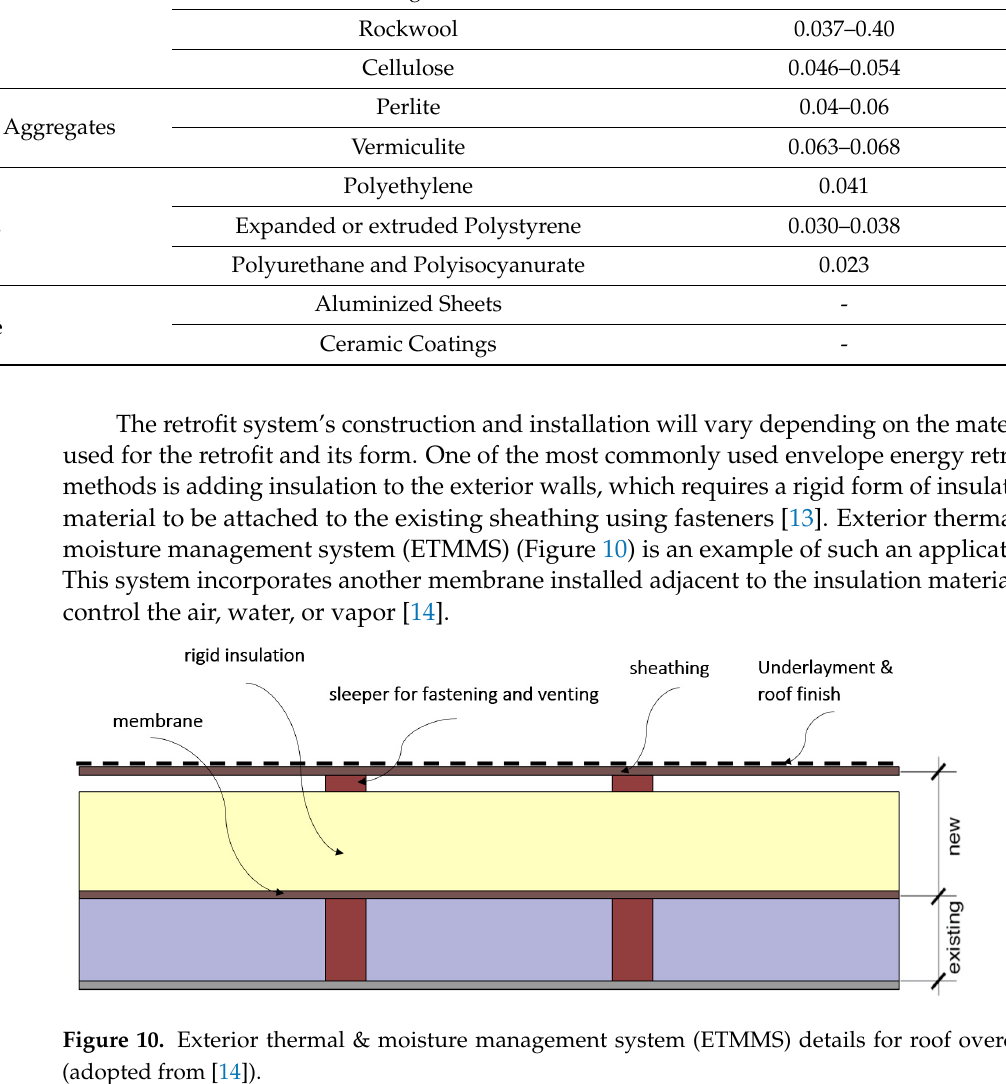
Table 3. Conventional types of insulation material (adopted from [10]).